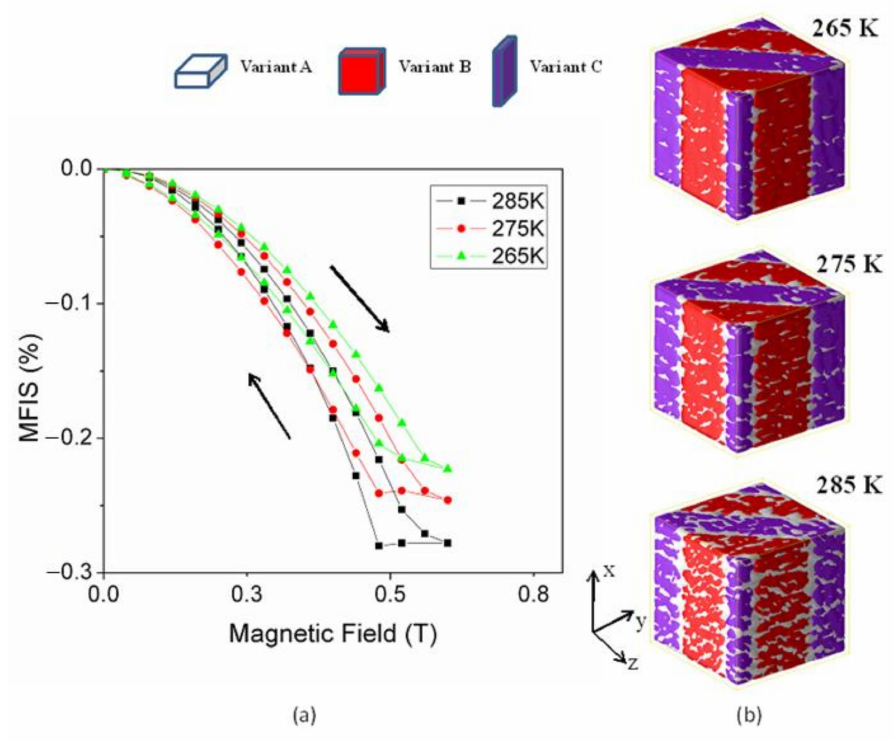
Figure 3. ( a )The MFIS loops at 285 K, 275 K and 265 K, respectively. ( b ) The simulated martensite variant structure at H x =0.6